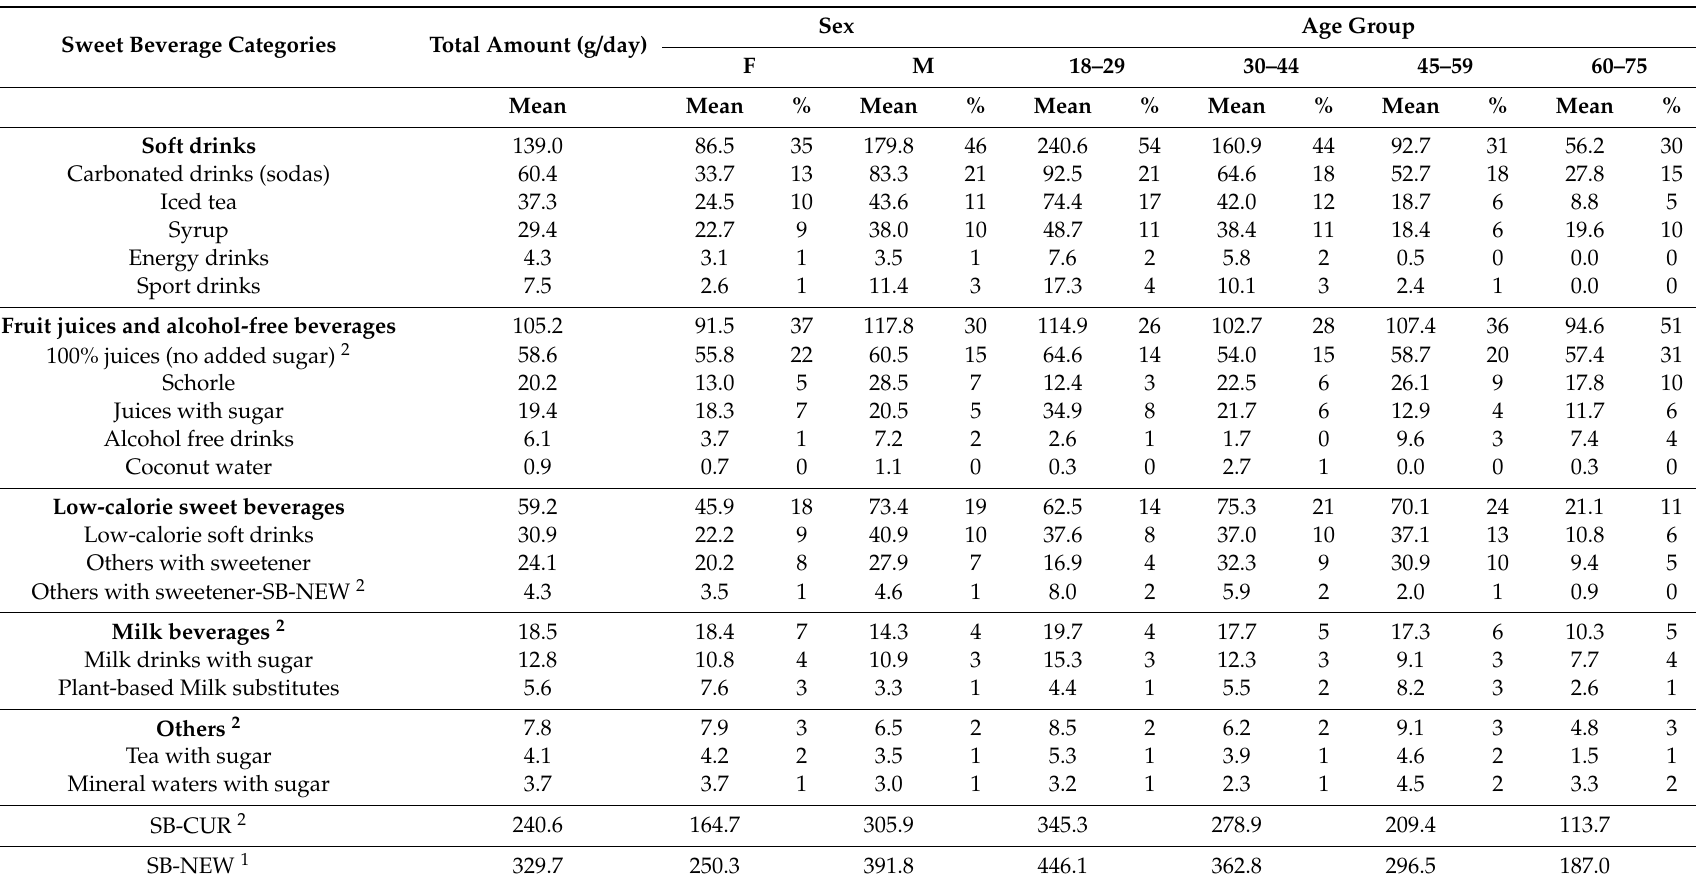
Table A2. Weighted-average consumption of sweet beverages (g / day) by gender and age